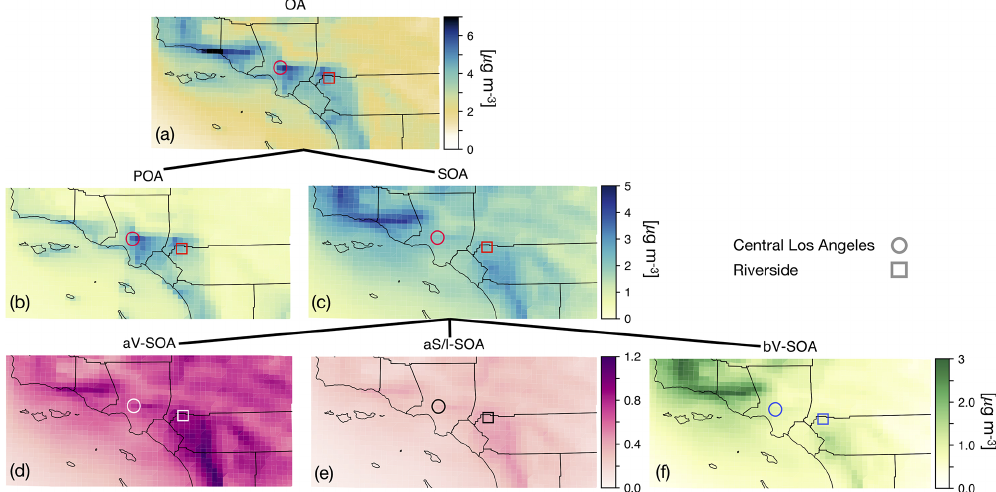
Figure 2. The 14-day-averaged model predictions of mass concentrations for OA, POA, SOA, aV-SOA, aS/I-SOA, and bV-SOA in µgm − 3 over the southern California domain from the Base simulation. We note that recent measurements suggest that POA from food cooking sources is less volatile than assumed in these